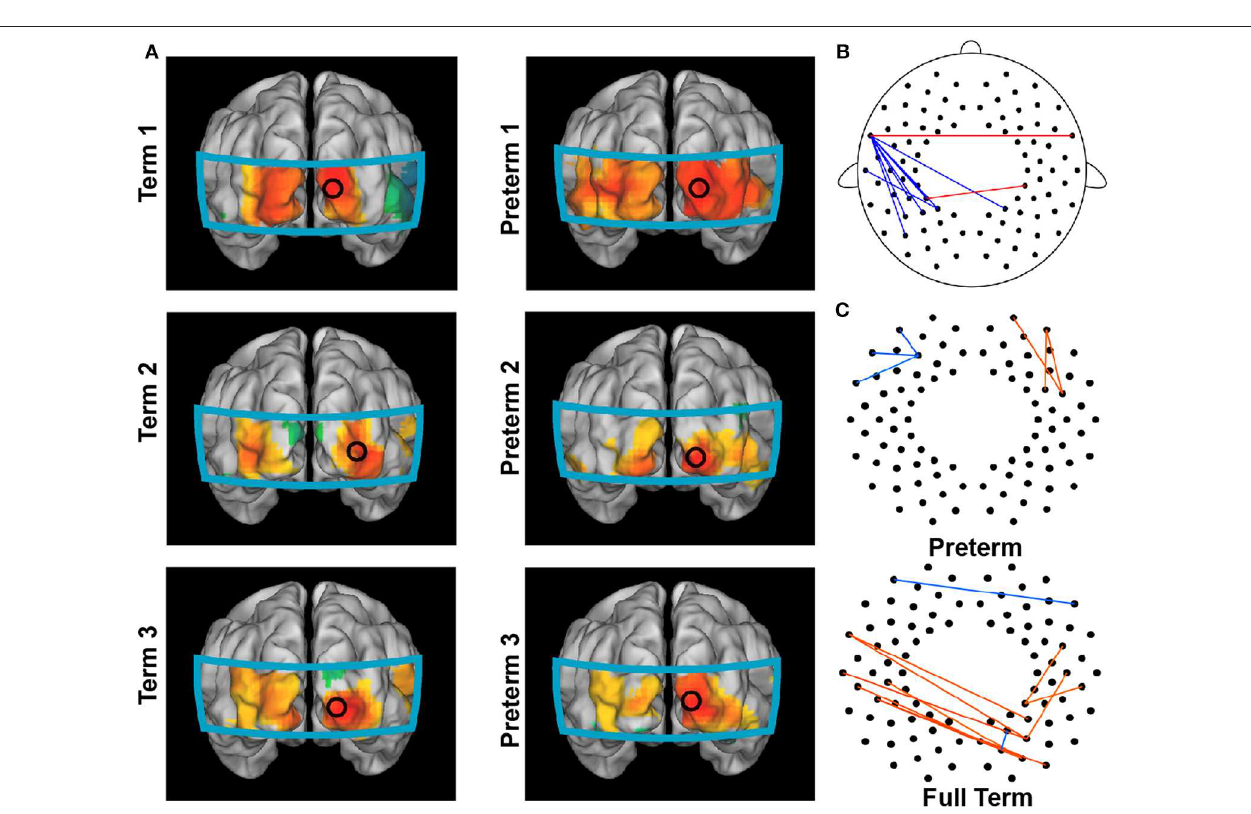
FIGURE 7 | Brain connectome in preterm infants. (A) Functional connectivity maps in full-term infants (left column) and preterm infants (right column) with the seed located in the right occipital region. (B) Group differences between preterm and full-term infants in functional connectivity. Red lines indicate the enhanced connections of preterm infants, and blue lines indicate the decreased connections of preterm infants compared to those of full-term infants. (C) Connections exhibiting significant correlations between normalized functional connectivity and postmenstrual age at the time of the scan in preterm (up) and full-term (bottom) infants. (A) is adapted from White et al. (2012) with permission from Elsevier; (B,C) are adapted from Fuchino et al. (2013) under a CC BY 4.0 license.